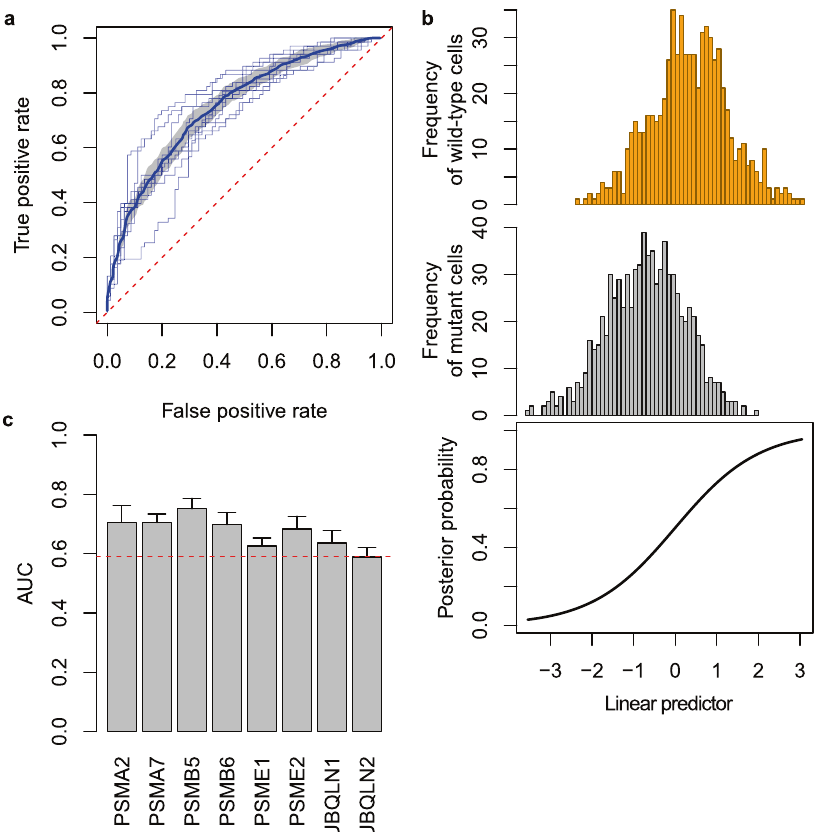
Fig. 2 Evaluation of the discriminative models for mutant cells. a Receiver operating characteristic (ROC) curves in the discrimination of PSMB5 mutant cells from wild-type cells. Thin blue lines represent ROC curves calculated with tenfold cross-validation. Thick blue line and gray area represent the mean and the quartile of the ROC curves, respectively. b Relationship between posterior probabilities and linear predictors of the discriminative model for PSMB5 mutant cells. Upper and middle plots show the distributions of linear predictors of wild-type cells and mutant cells, respectively. Lower plot shows a sigmoid curve between posterior probabilities and linear predictors. c AUC of the discriminative model for each mutant cell type. The error bar shows the standard deviation in tenfold cross-validation. Red dashed line represents AUC =